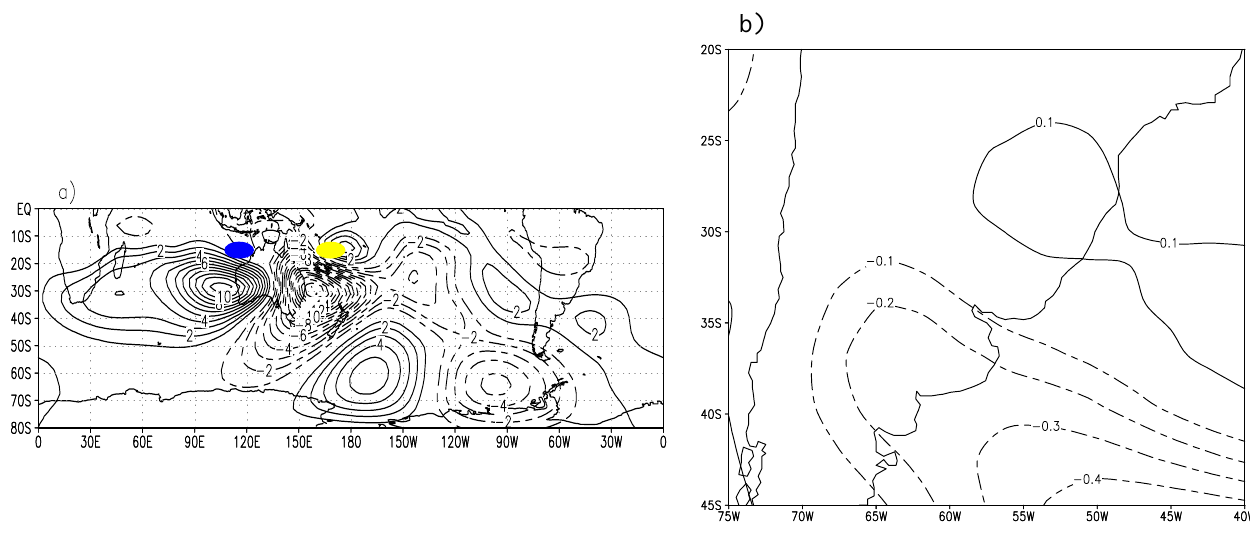
Fig. 5. Same as Fig. 4 but using − σ basic state.